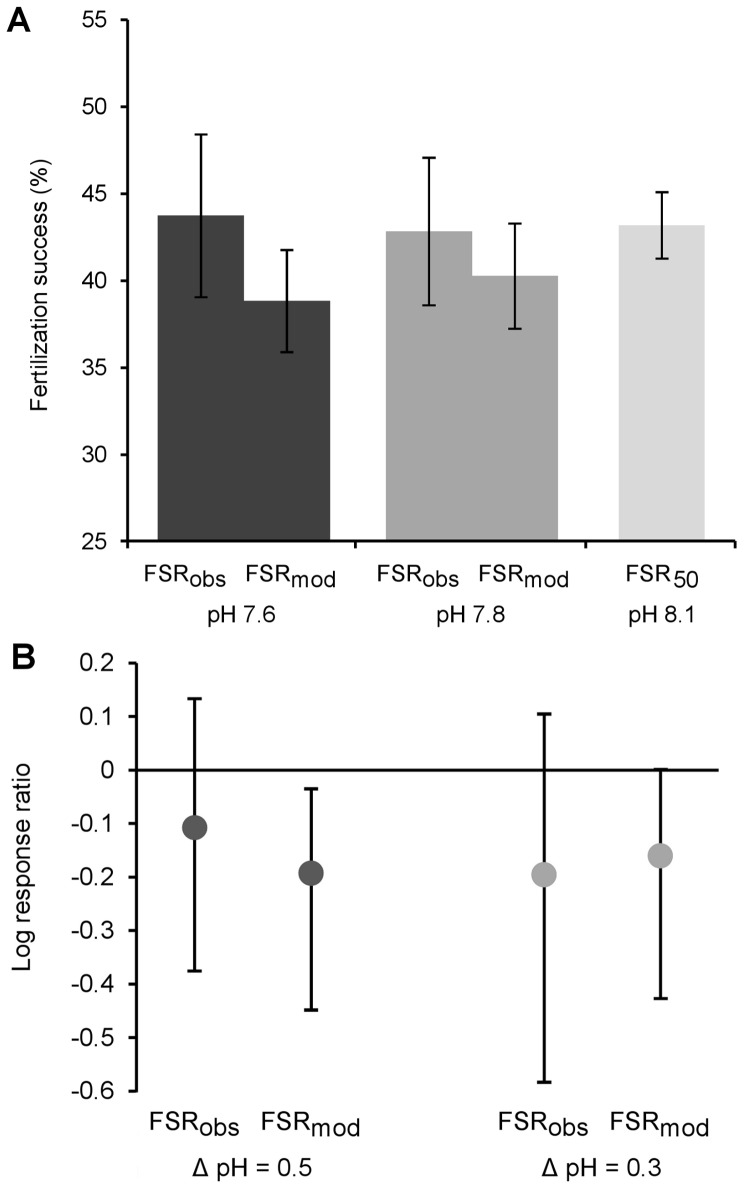
Effects of ocean acidification on fertilization success (FSR) in H. erythrogramma.(A) Mean (±S.E.) observed (FSRobs) and modelled fertilization success (FSRmod) for pHs 7.6 and 7.8, and mean (±S.E.) FSR50 (50% of maximum FSR) for pH 8.1. (B) Bootstrapped mean logarithmic response ratios (±95% CI) of effects of ocean acidification on FSRobs and FSRmod. FSRmod shows change in fertilization success expected due to ocean acidification’s influence on sperm swimming behaviour (Fig. 2C). (n = 18 replicate trials). See text for details.